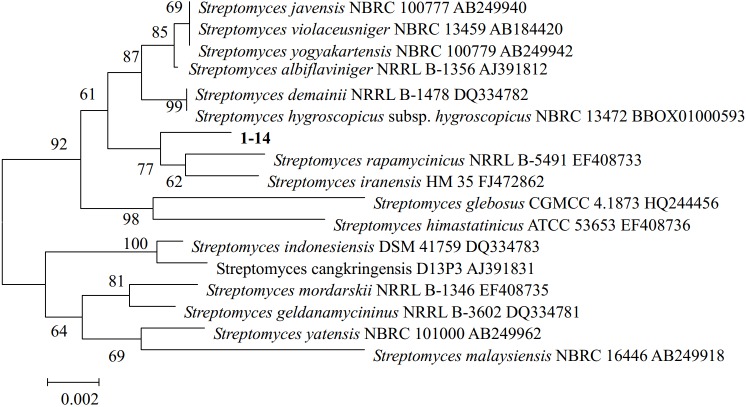
Phylogenetic tree of 16S rDNA gene sequences of strain 1–14.